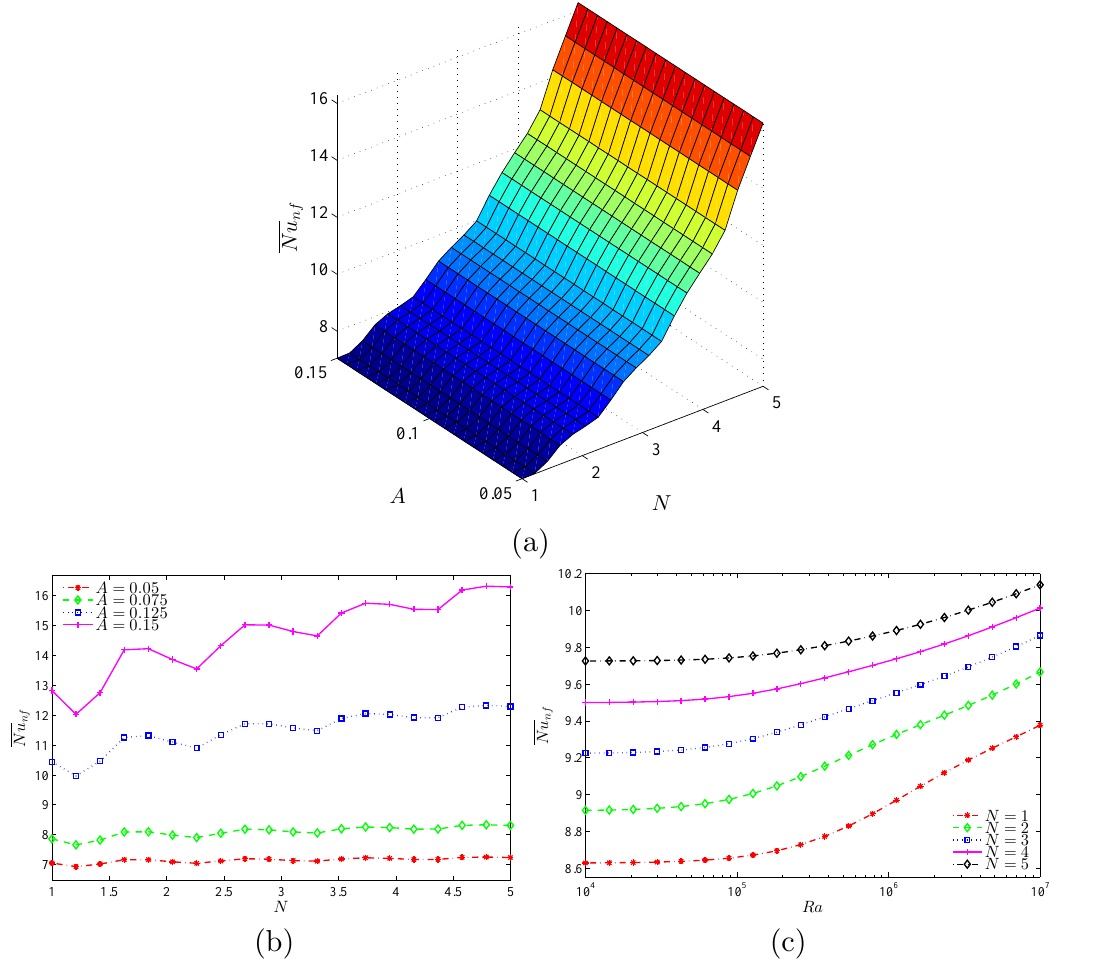
Figure 11. ( a ) 3D-plot of the average Nusselt number with N and A , ( b ) variation of the average Nusselt number with N for different A , and ( c ) variation of the average Nusselt number with Ra for different N at φ =